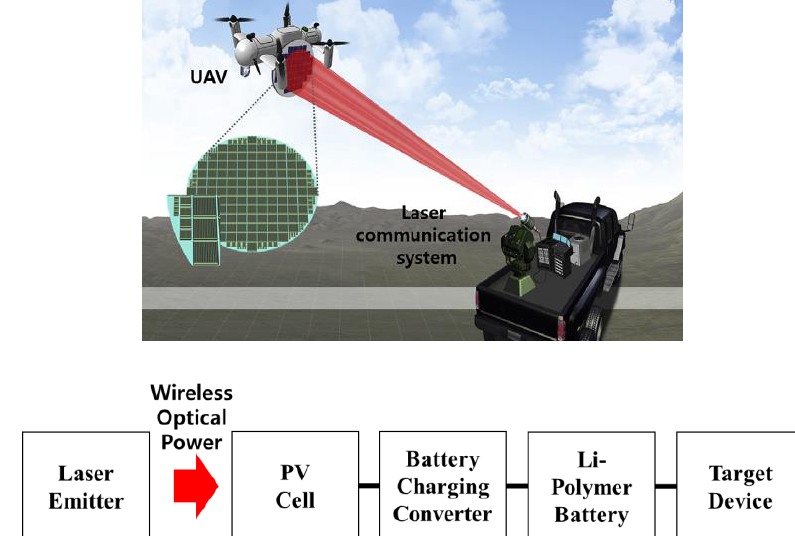
Figure 1. Laser wireless charging system configuration of unmanned aerial vehicle (UAV) [5].